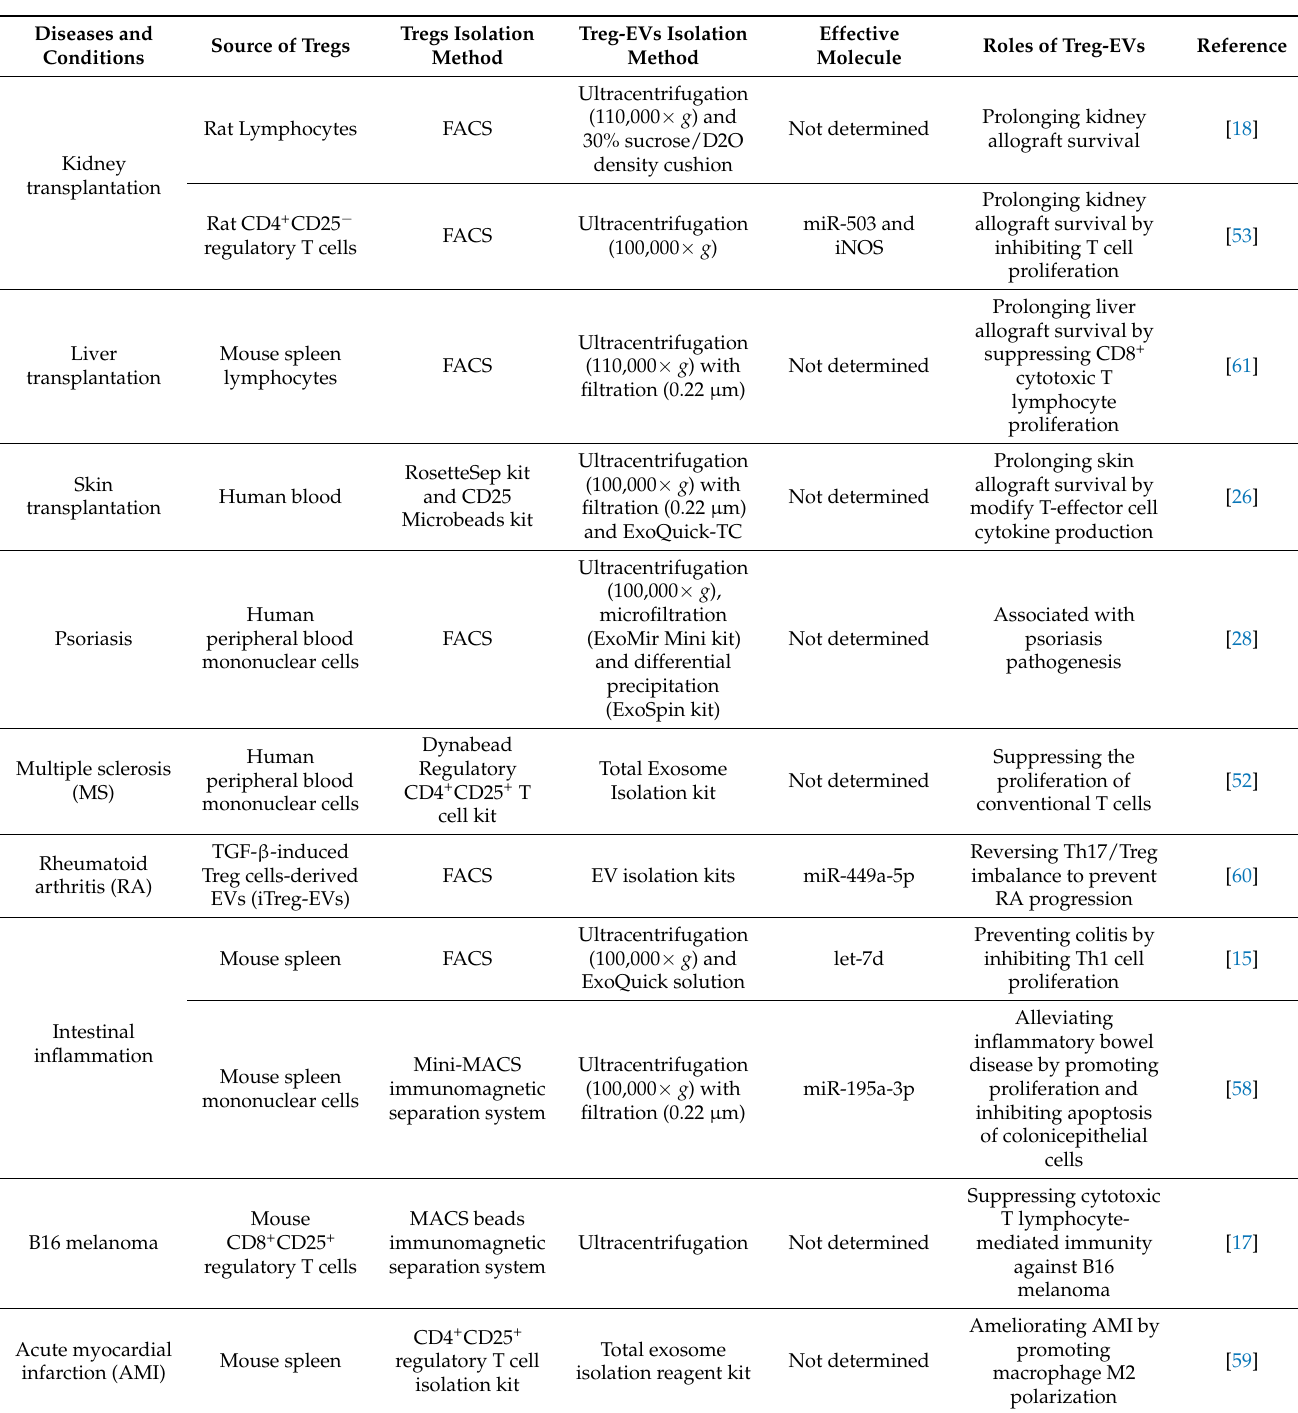
Table 2. Heterogeneity of Treg cell-derived EVs in studies and their roles in human diseases and